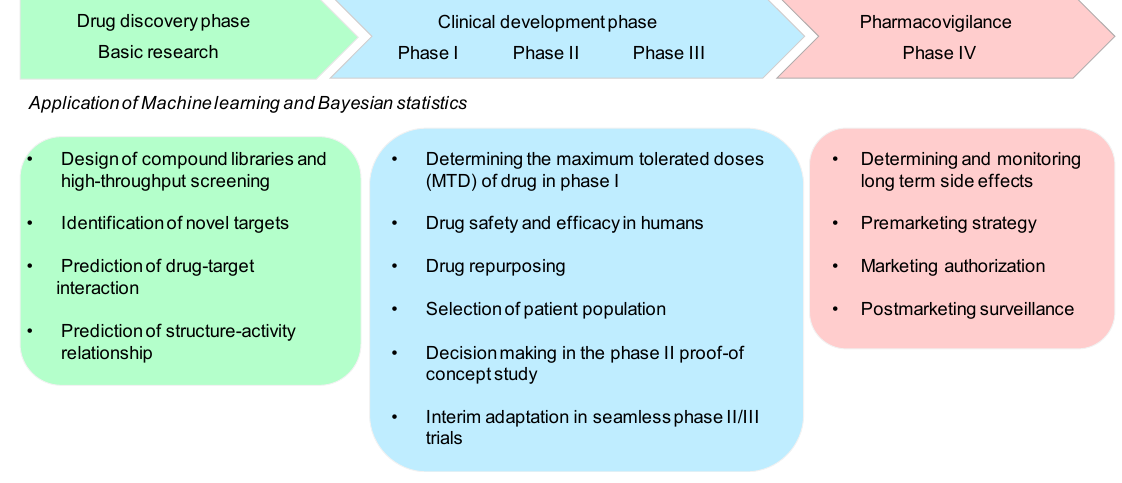
Figure 3. Application of machine learning and Bayesian statistics in different phases of drug development.